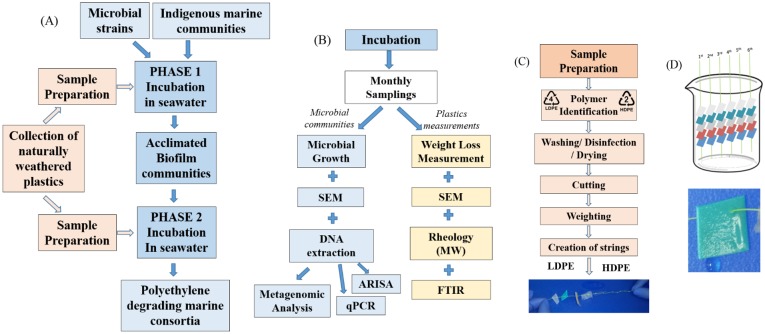
Experimental design.Schematic presentation of A) the experimental sequence; B) incubation and measurements of plastic properties and the microbial community, C) Sample preparation steps for setting up the strings with the plastic pieces, D) growth vessel with labelled strings with weathered plastic pieces of size 1 cm2 and biofilm development on plastic pieces.